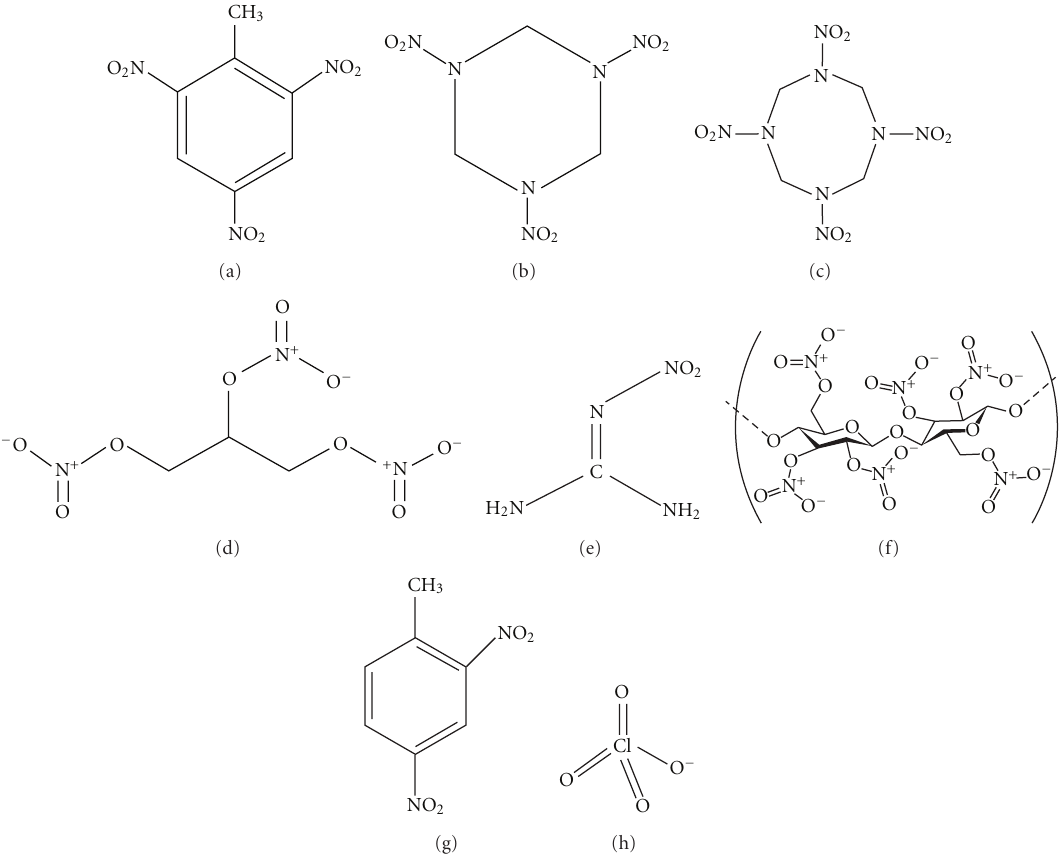
Figure 1: Chemical structures of energetic compounds: (a) 2,4,6-trinitrotoluene (TNT); (b) hexahydro-1,3,5-trinitro-1,3,5-triazine (RDX); (c) octahydro-1,3,5,7-tetranitro-1,3,5,7-terazocine (HMX); (d) nitroglycerin (NG); (e) nitroguanidine (NQ); (f) nitrocellulose (NC);